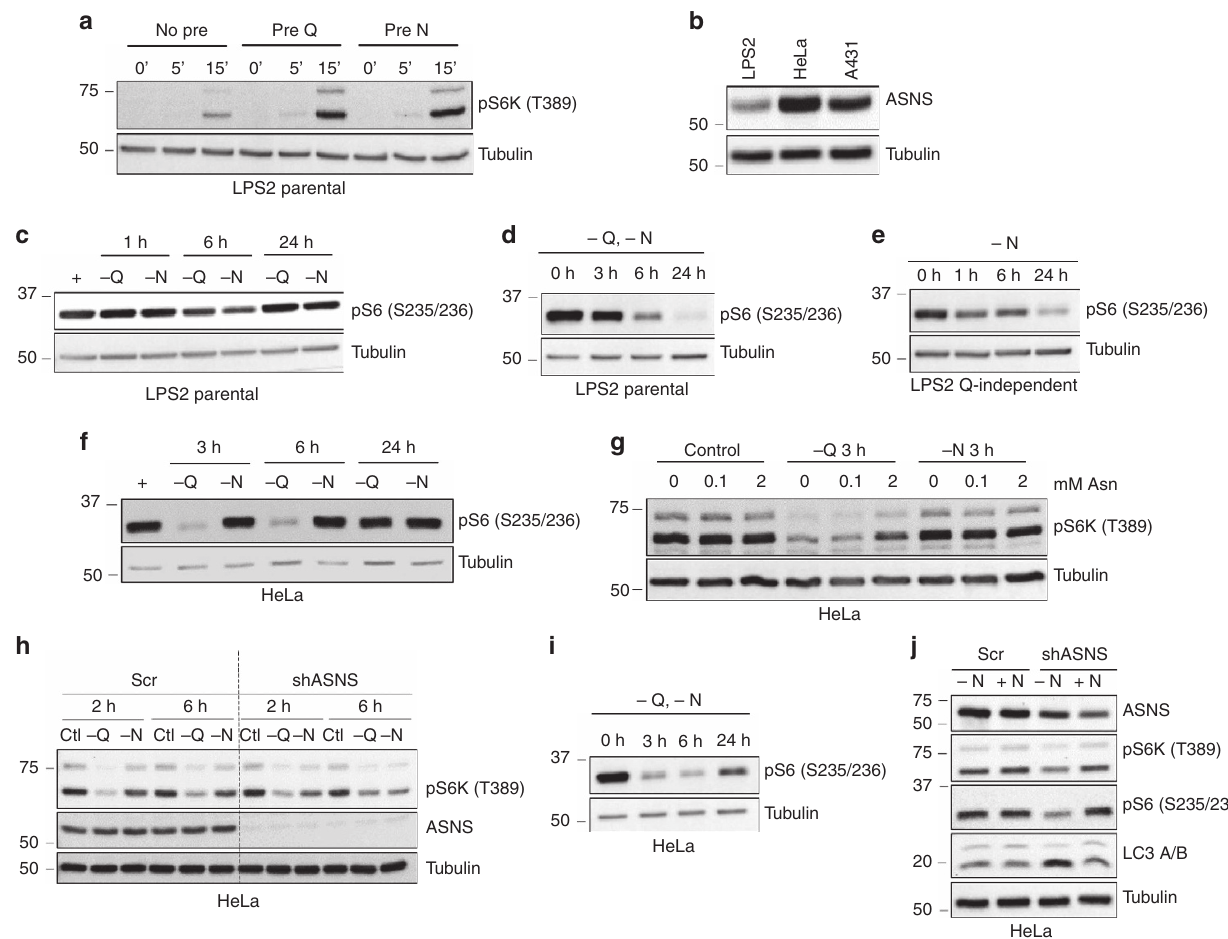
Figure 5 | Asparagine regulates mTORC1 activation and autophagy. ( a ) Immunoblotting of lysates from serum- and amino acid-starved LPS2 parental cells pre-loaded with starve medium (No pre), glutamine (Pre Q) or asparagine (Pre N), followed by amino acid stimulation for 0, 5 or 15min. Lysates were probed with a phospho-specific antibody towards the mTOR target S6K at T389 and with anti-tubulin. ( b ) Immunoblot comparing ASNS levels in lysates from LPS2, HeLa and A431 cells under non-starved conditions. ( c ) Immunoblot showing phosphorylation of downstream mTOR effector S6 ribosomal protein (S235/236) following starvation of LPS2 parental cells of glutamine ( (cid:2) Q) or asparagine ( (cid:2) N) for the indicated times. ‘ þ ’ indicates no starvation. ( d ) Immunoblot showing S6 ribosomal protein phosphorylation (S235/236) following glutamine and asparagine starvation of LPS2 parental cells for the indicated times. ( e ) Immunoblot showing S6 ribosomal protein phosphorylation (S235/236) following asparagine starvation of LPS2 glutamine- independent cells for the indicated times. ( f ) Immunoblot showing S6 ribosomal protein phosphorylation (S235/236) following starvation of HeLa cells of glutamine ( (cid:2) Q) or asparagine ( (cid:2) N) for the indicated times. Prior to withdrawal, the medium contained 2mM glutamine and 0.1mM asparagine. ( g ) Immunoblot showing S6K phosphorylation (T389) following starvation of HeLa cells of glutamine ( (cid:2) Q) or asparagine ( (cid:2) N) for 3h. Prior to starvation, cells were cultured for 7 days in DMEM supplemented with the indicated asparagine concentration. ( h ) Immunoblot showing phosphorylation of S6K (T389) in HeLa cells stably expressing scrambled shRNA or ASNS shRNA with and without (Ctl) starvation of glutamine ( (cid:2) Q) or asparagine ( (cid:2) N) for the indicated times. ( i ) Immunoblot showing S6 ribosomal protein phosphorylation (S235/236) following glutamine and asparagine starvation of HeLa cells for the indicated times. ( j ) Immunoblot of HeLa lysates 48h post doxycycline-induced expression of scrambled shRNA or ASNS shRNA in asparagine-free DMEM ( (cid:2) N) or DMEM supplemented with 0.1mM asparagine ( þ N). Lysates were immunoblotted for autophagy marker LC3-II (bottom band), mTOR activity markers pS6K and pS6, and